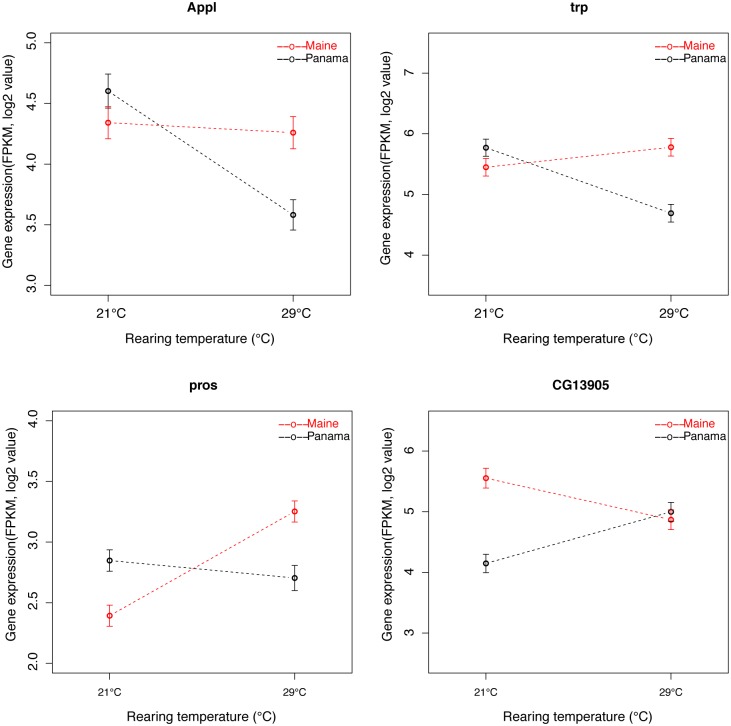
Example of D. melanogaster genes exhibiting population-by-temperature interaction.
Appl and trp represent typical genes showing greater expression differences at 29°C than 21°C.